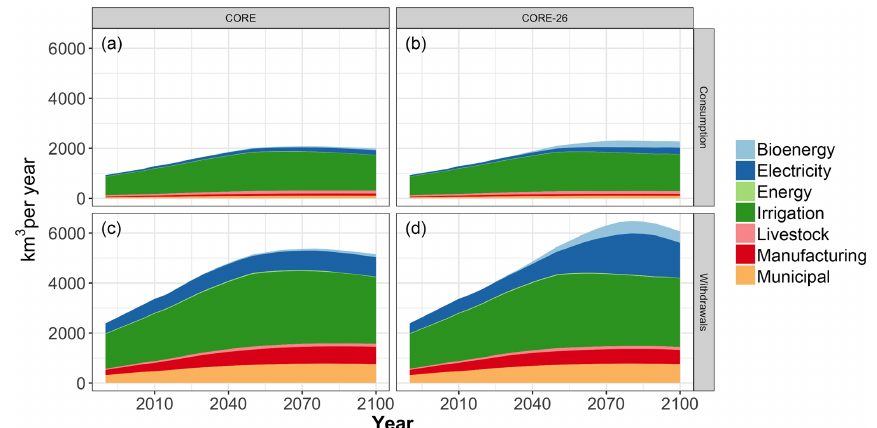
Figure 9. Global water consumption (a, b) and global water withdrawals (c, d) by sector for the CORE (a, c) and CORE-26 (b, d) scenarios. Data are aggregated from technology to sector for plotting